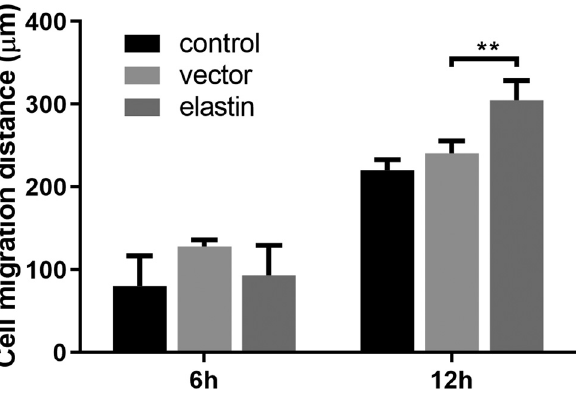
Figure 7: Migration distance calculation of BMSCs with di ff erent treatments after incubating for 6 and 12